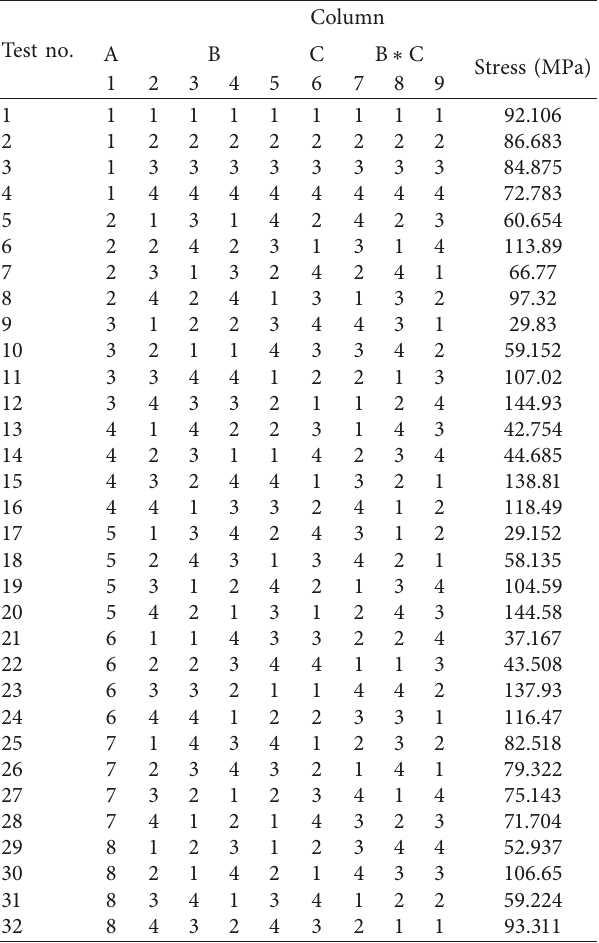
Table 3: Experimental program of orthogonal analysis with mixed levels. Test no.